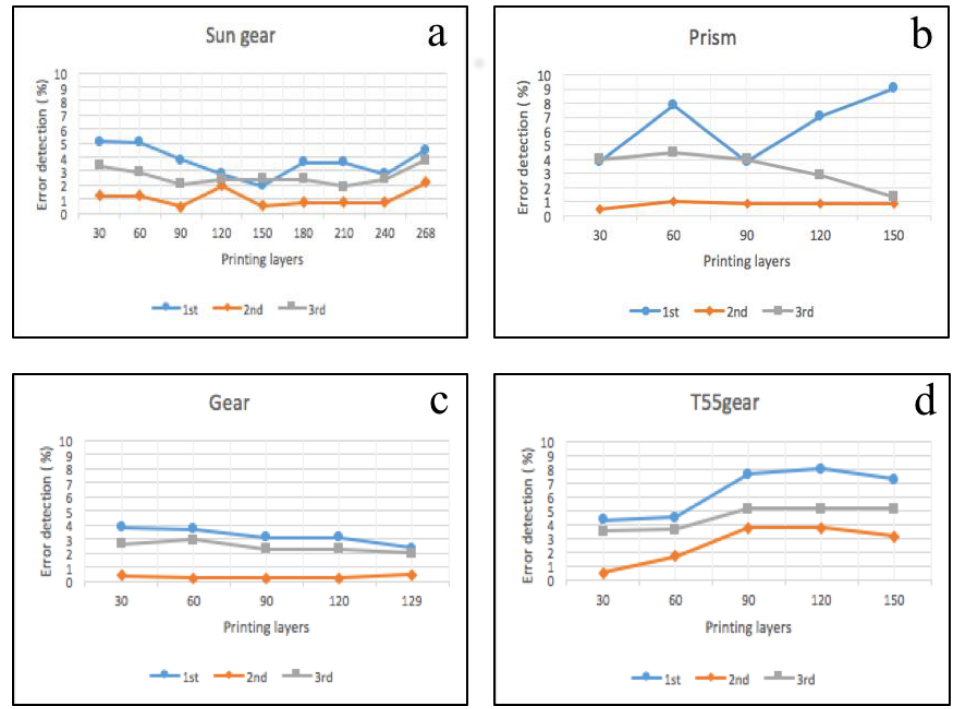
Figure 18. Error detection—Horizontal magnitude: the error detection of normal printing state for ( a ) sun gear; ( b ) Prism; ( c ) gear; and ( d ) t55gear.